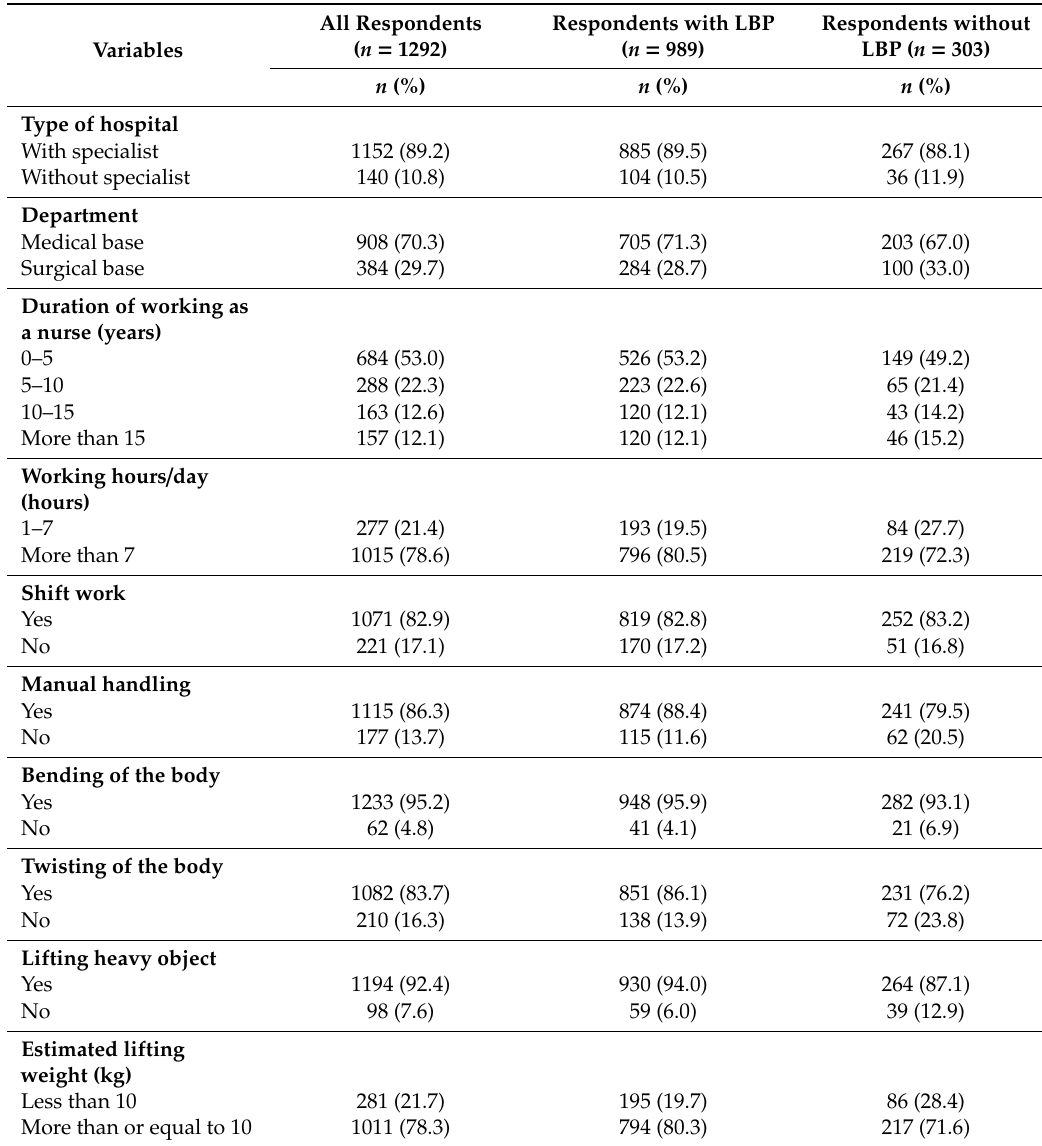
Table 3. Occupational characteristics of the